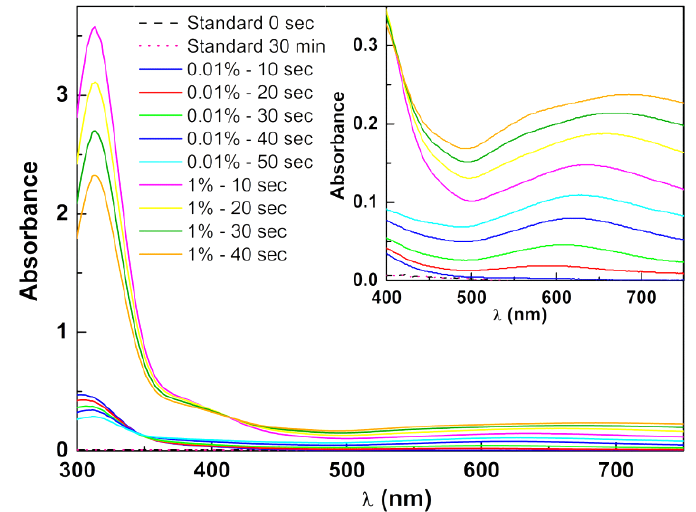
Figure 4. Absorption spectra of nickel ferrite / gold core / shell nanoparticles with increasing time, after addition of hydroxylamine and chloroauric acid (0.01% and 1%).